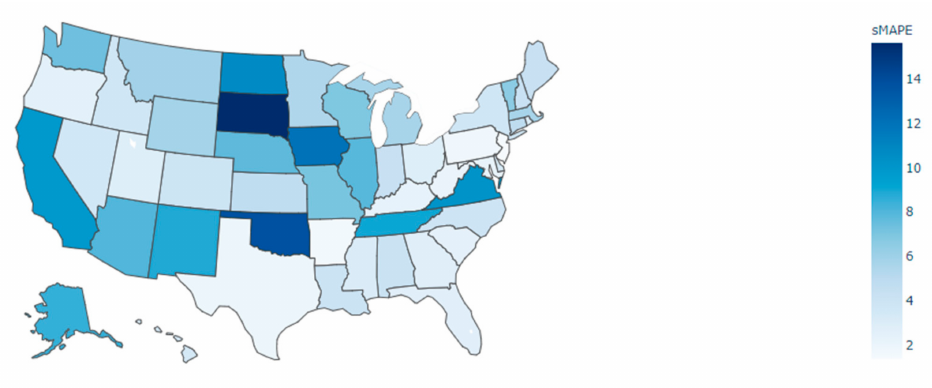
Figure 8. Average sMAPE for all states in the US using predictions from the GTNN